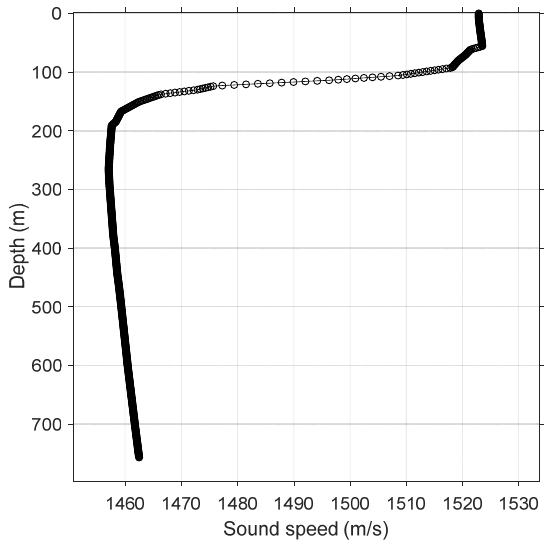
Figure 6. Sound speed profile.